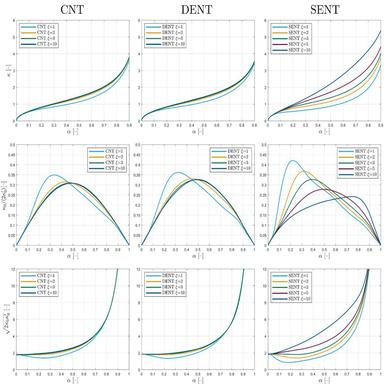
Variation in κ (top row), intrinsic size factor (centre row), and intrinsic nominal strength factor (bottom row), with ξ, for the three main geometries of interest (CNT, DENT, and SENT).